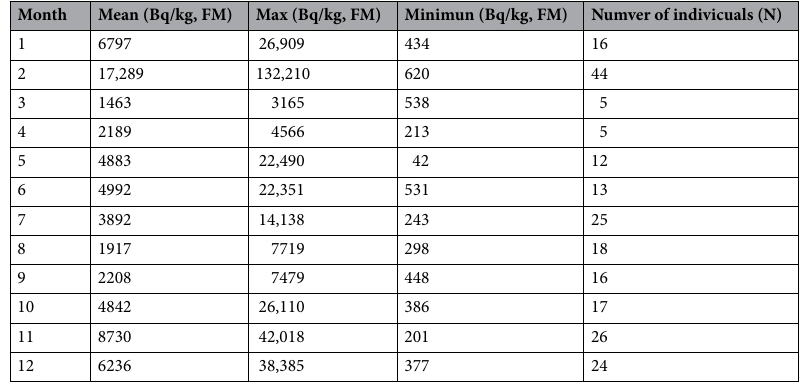
Table 2. 137 Cs activity concentration in wild boars muscle of each month in difficult to return zone.